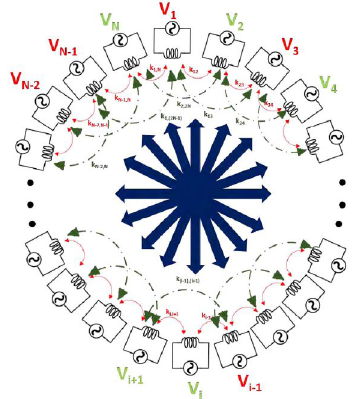
Figure 2. Multiple access WPT network presented in [23].